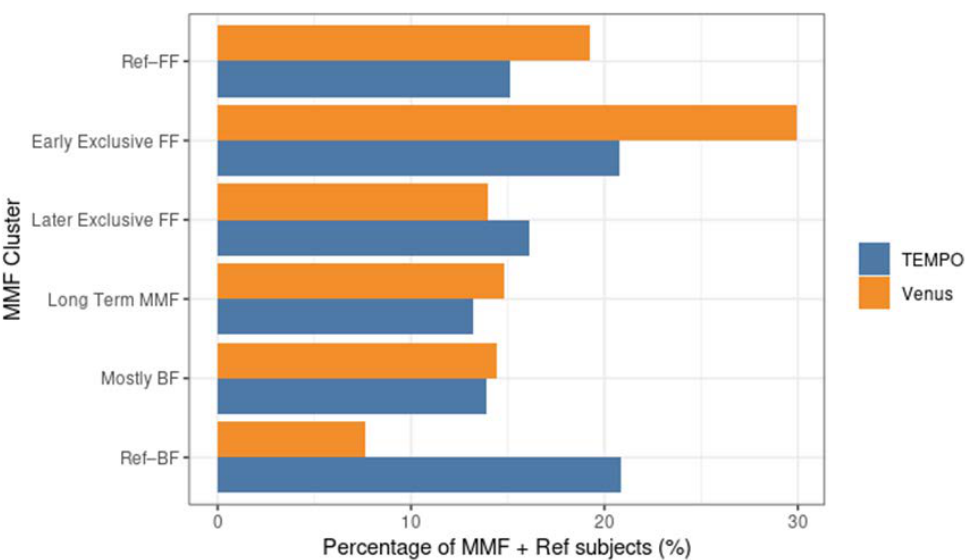
Figure 1. Percentage of subjects in different MMF clusters and reference groups in the MMF + Ref population for Tempo and Venus. FF: formula feeding; BF: breastfeeding; MMF: Mixed milk Feeding; Ref–BF: Subjects who had no, or limited infant milk formula intake recorded during the first year (on ≤ 5% of total recorded days) .